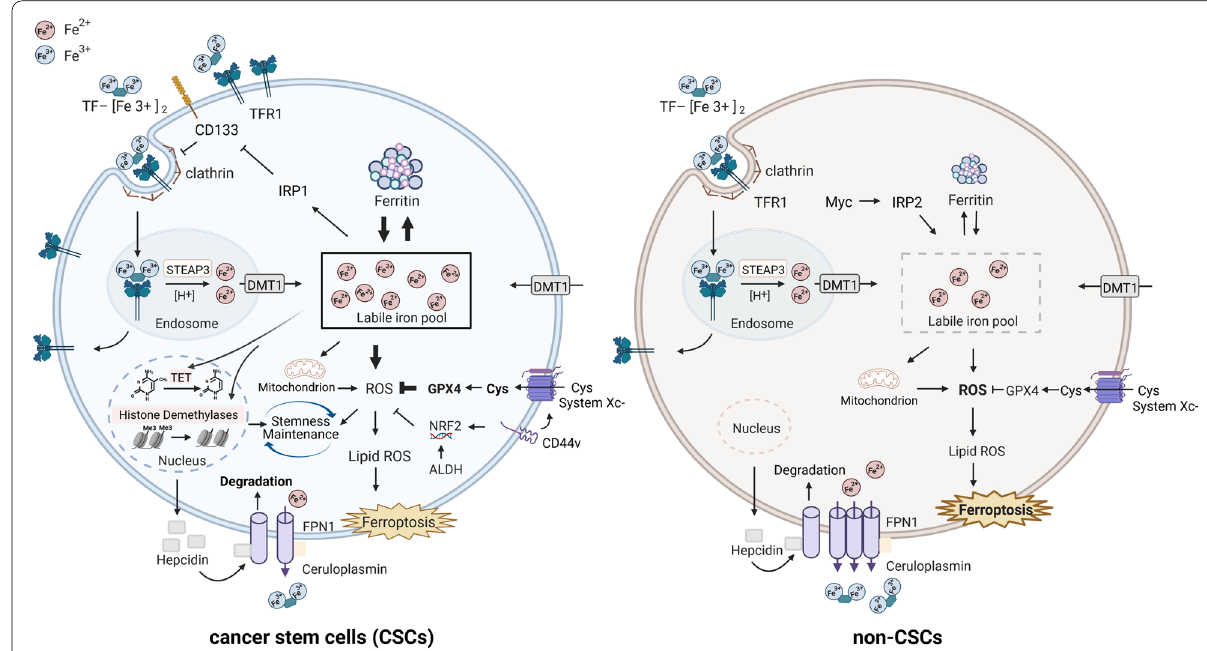
Fig. 1 Iron metabolism in cancer stem cells (CSCs) and non-CSCs. CSCs and non-CSCs differently express proteins implicated in iron trafficking. CSCs possess an augmented accumulation of intracellular iron and iron-dependent maintenance and expansion via ROS and epigenetic reprogramming, resulting in therapy resistance. Moreover, compared to non-CSCs, CSCs possess nature resistance of rendering them sensitive to ferroptosis. ALDH, aldehyde dehydrogenase; CD44v, CD44 variant isoform; Cys, cystine; DMT1, divalent metal transporter 1; TF, transferrin; TFR1, transferrin receptor 1; FPN1, ferroportin 1; GPX4, glutathione peroxidase 4; IRP1/2, iron regulatory protein 1/2; NRF2, nuclear factor erythroid 2-related factor 2; ROS, reactive oxygen species; System Xc-, cystine/glutamic acid transporter; STEAP3, six epithelial transmembrane antigensof the prostate